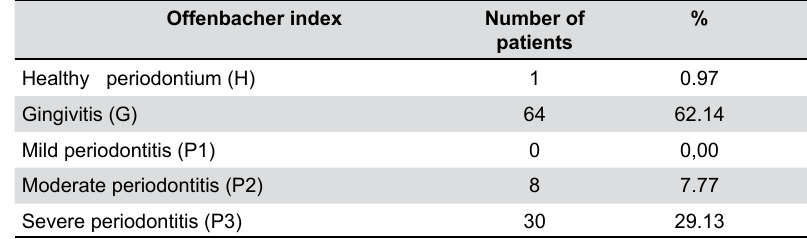
Table 2- Periodontal status in the dentate group according to the Offenbacher index; qualitative